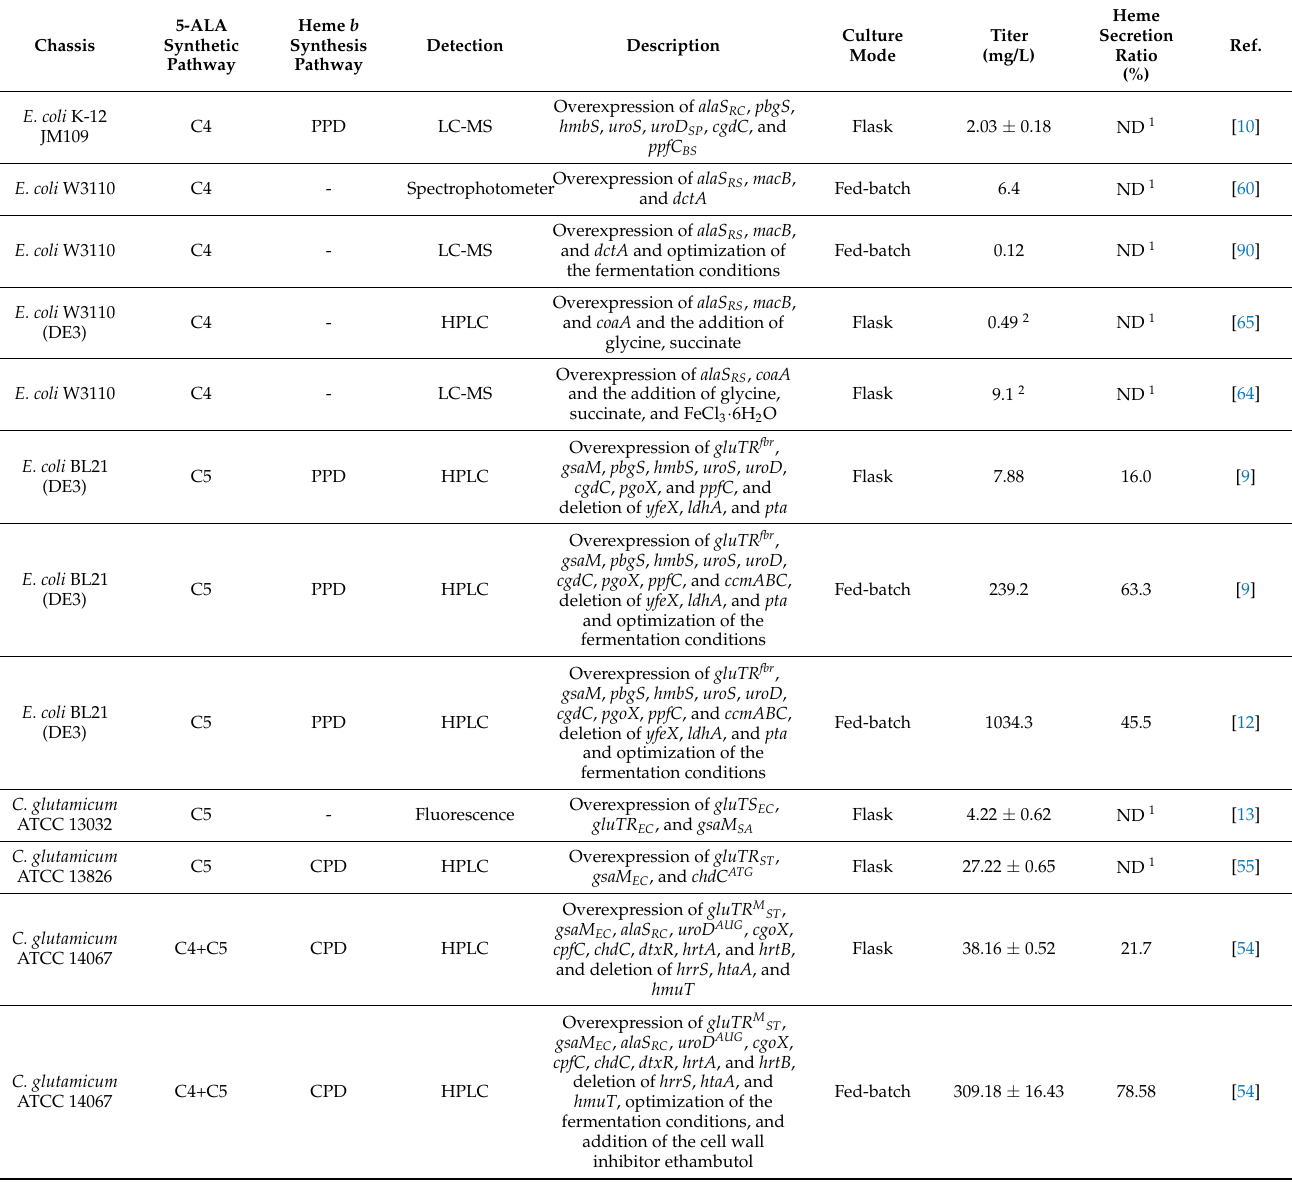
Table 1. Recent advances in the biosynthesis of heme b